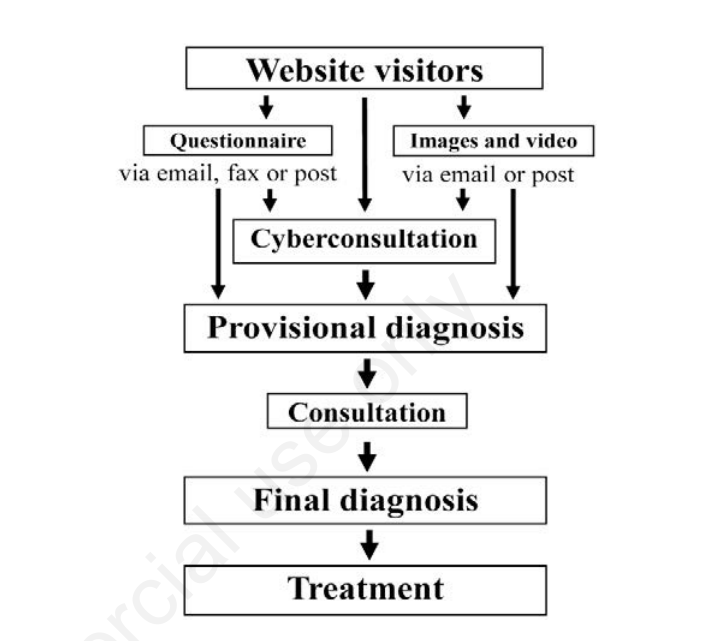
Figure 1. Procedure from diagnosis to treatment. We exclude diseases such as temporo- mandibular joint disorder or psychogenic disease based on information such as the patient’s questionnaire responses, images, and video, and then conduct further cybercon- sultations via Skype™. A final diagnosis is made after the patient visits our clinic.